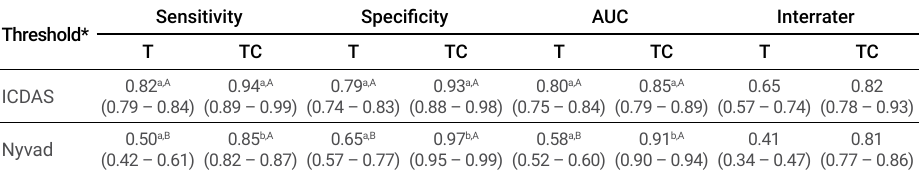
Table 1. Sensitivity, specificity, area under the ROC curve (AUC), and interrater reliability shown by dental students.